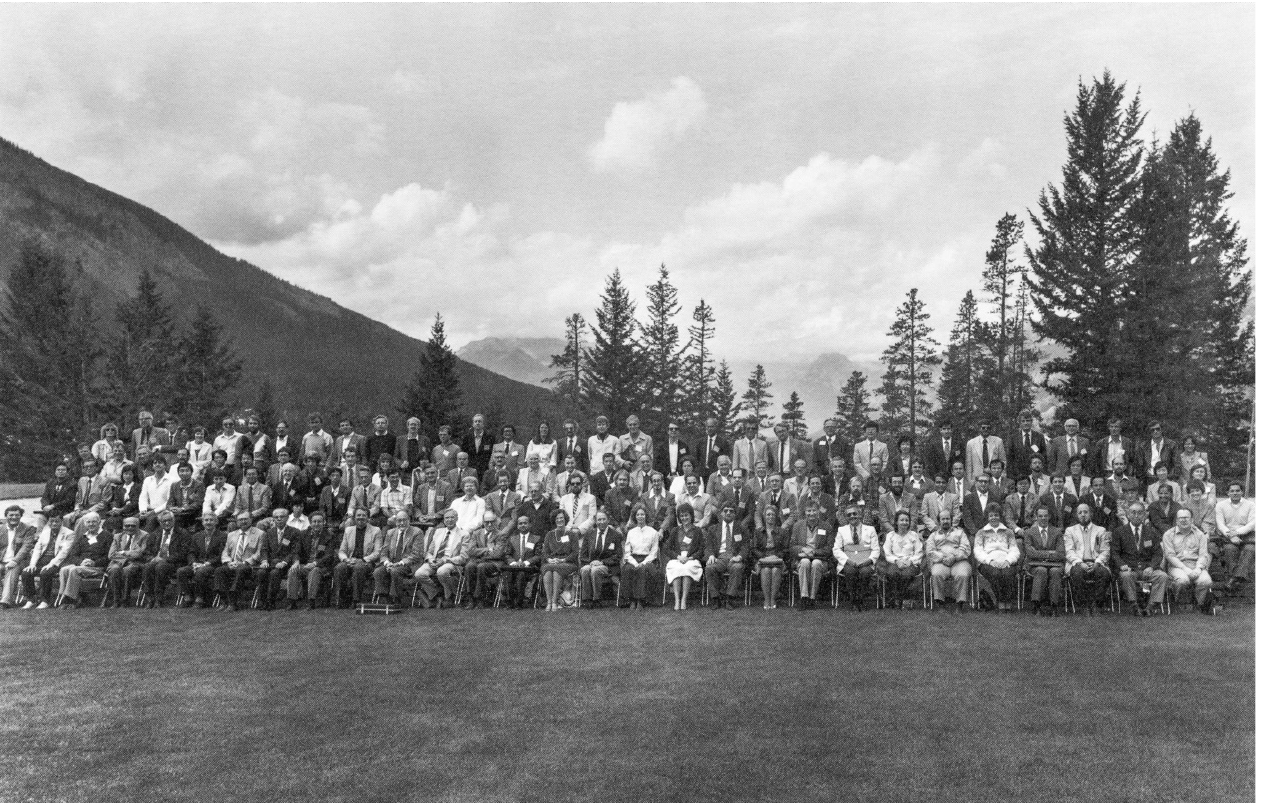
Figure 2. Participants in the conference on N -Nitroso Compounds: Occurrence, Biological Effects and Relevance to Human Cancer, sponsored by the International Agency for Research on Cancer (IARC), Agriculture Canada, and the Alberta Heritage Foundation for Medical Research in Banff, Canada, 5–9 September 1983. (Reprinted with permission of the IARC).